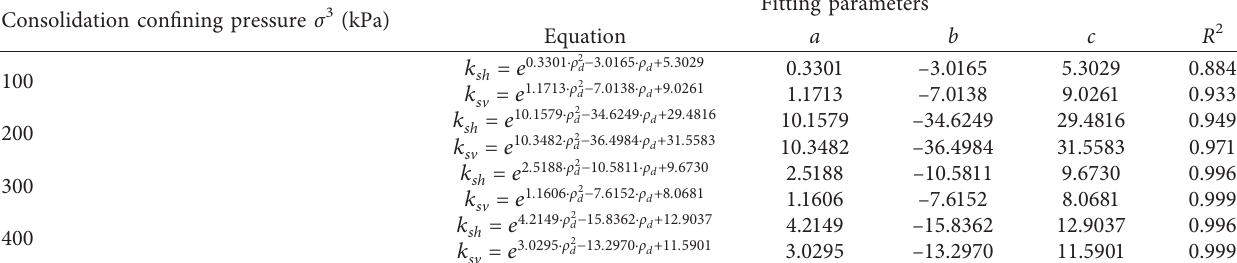
Table 8: Fitting parameters under K